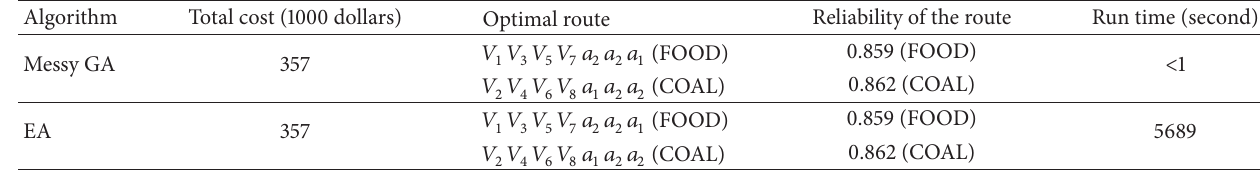
Table 3: Comparison of two